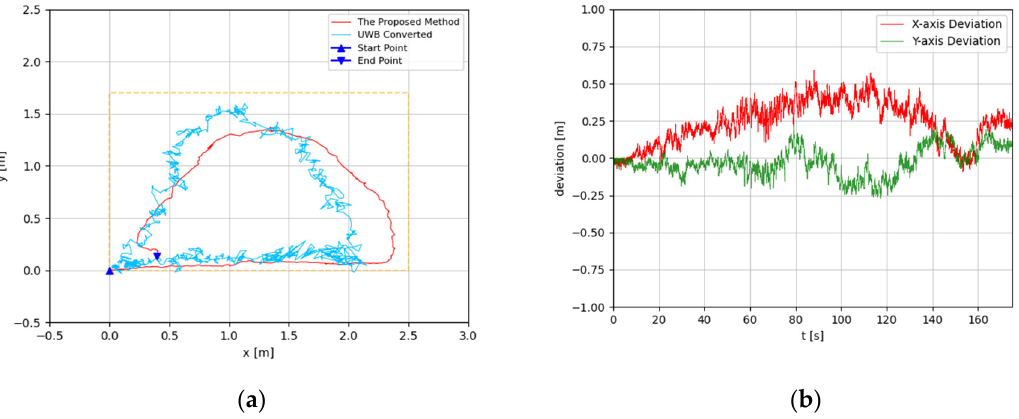
Figure 11. ( a ) Trajectory of triangle-shaped path in the second test; ( b ) Positioning comparison of triangle-shaped path in the second test.